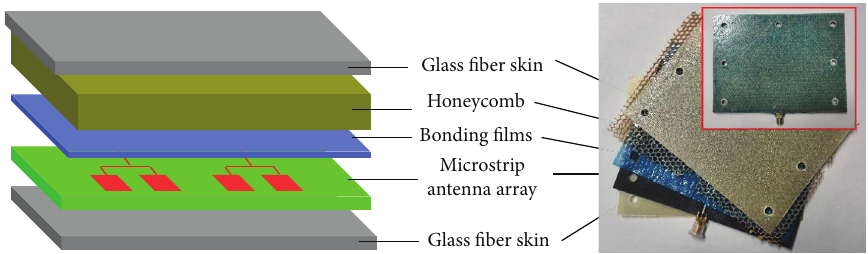
Figure 1: Conformal load-bearing antenna structure (CLAS) with microstrip antennas.